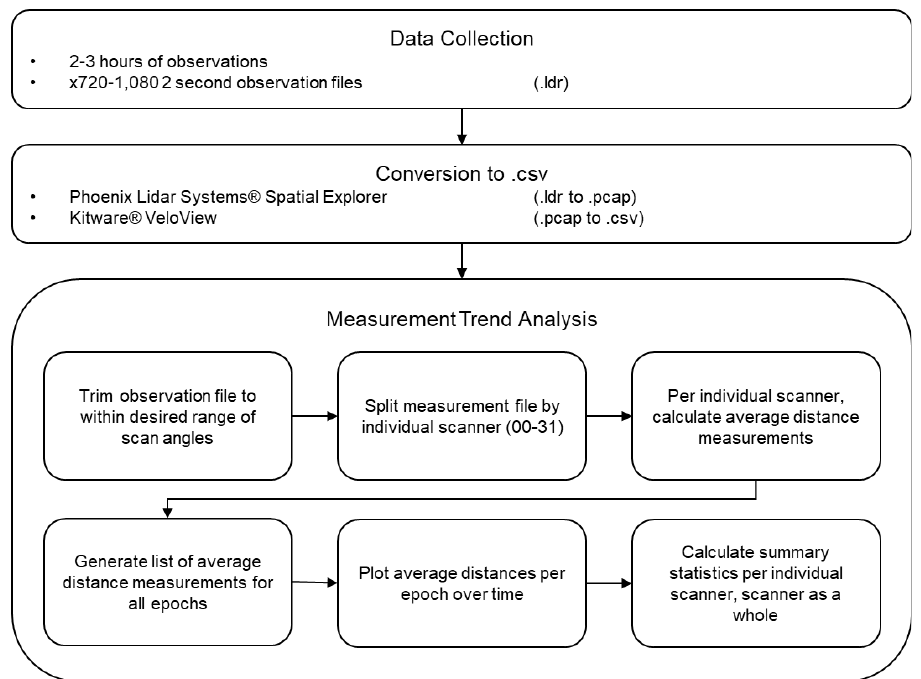
Figure 6. Velodyne ® HDL – 32E measurement analysis workflow.